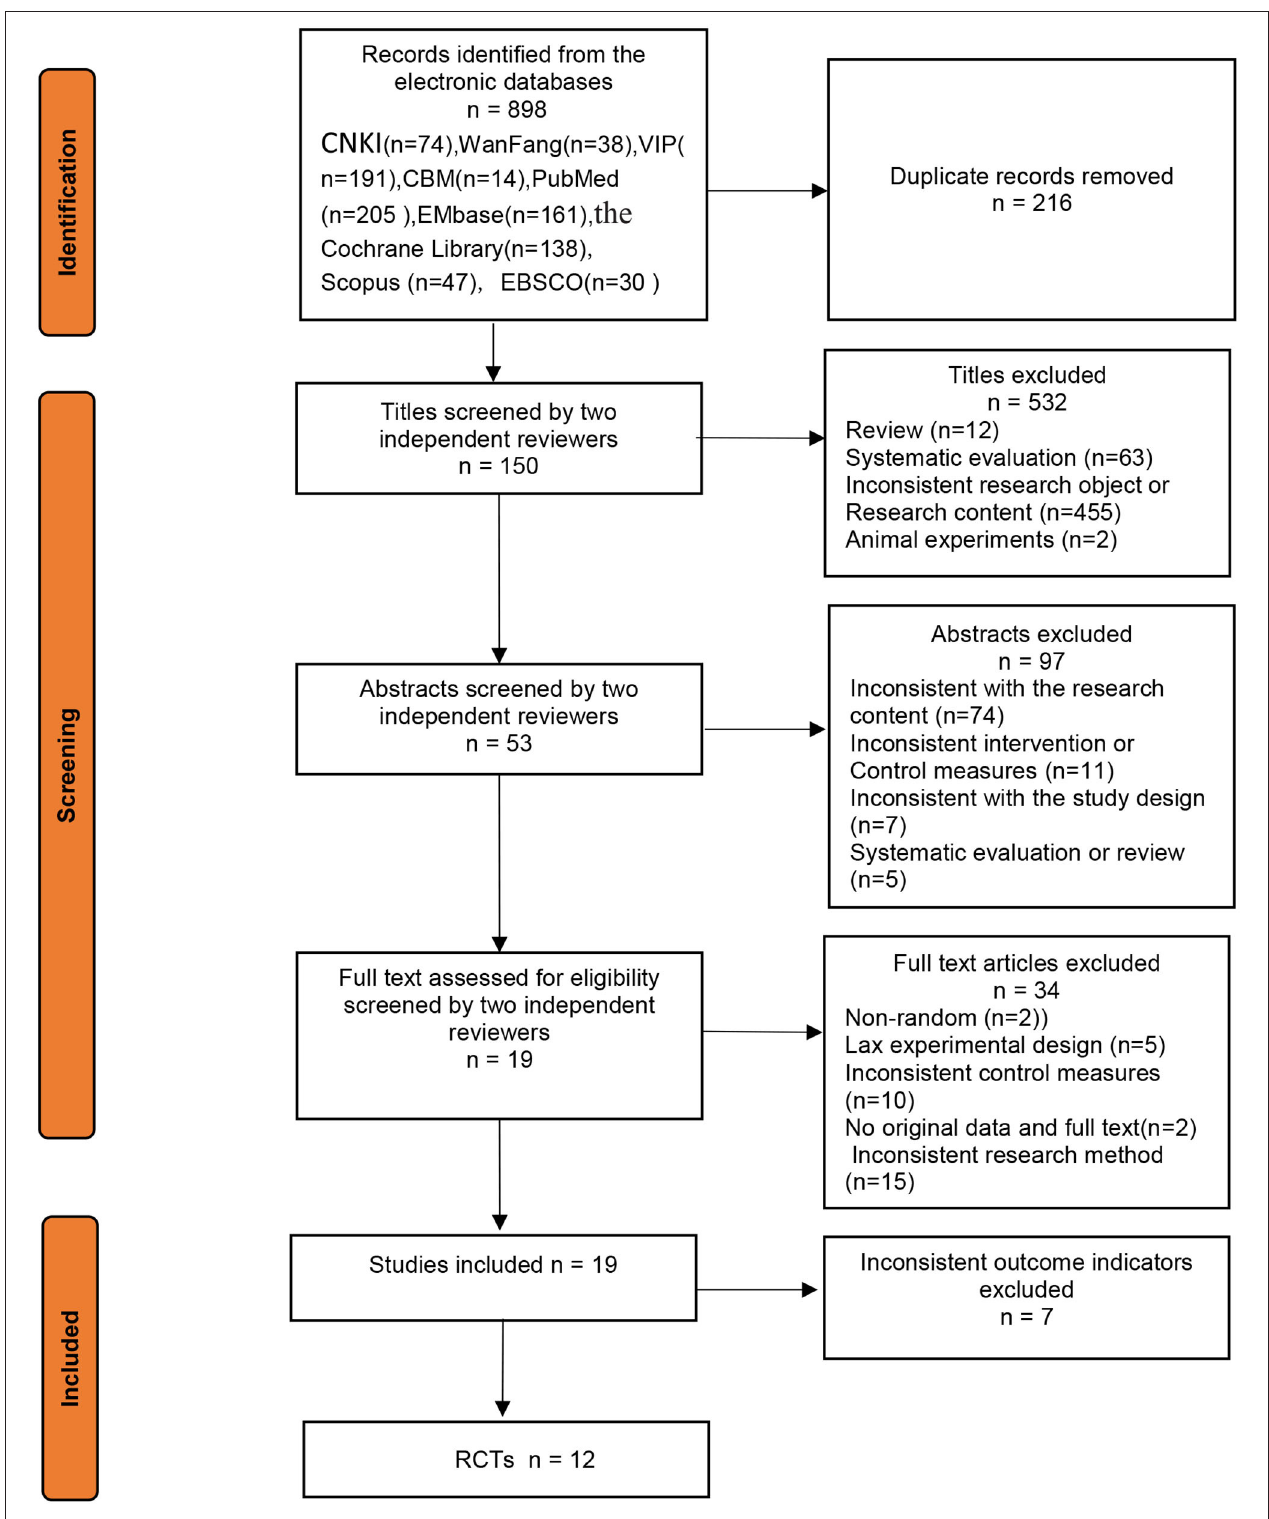
FIGURE 1 | Flow diagram of literature search and selection